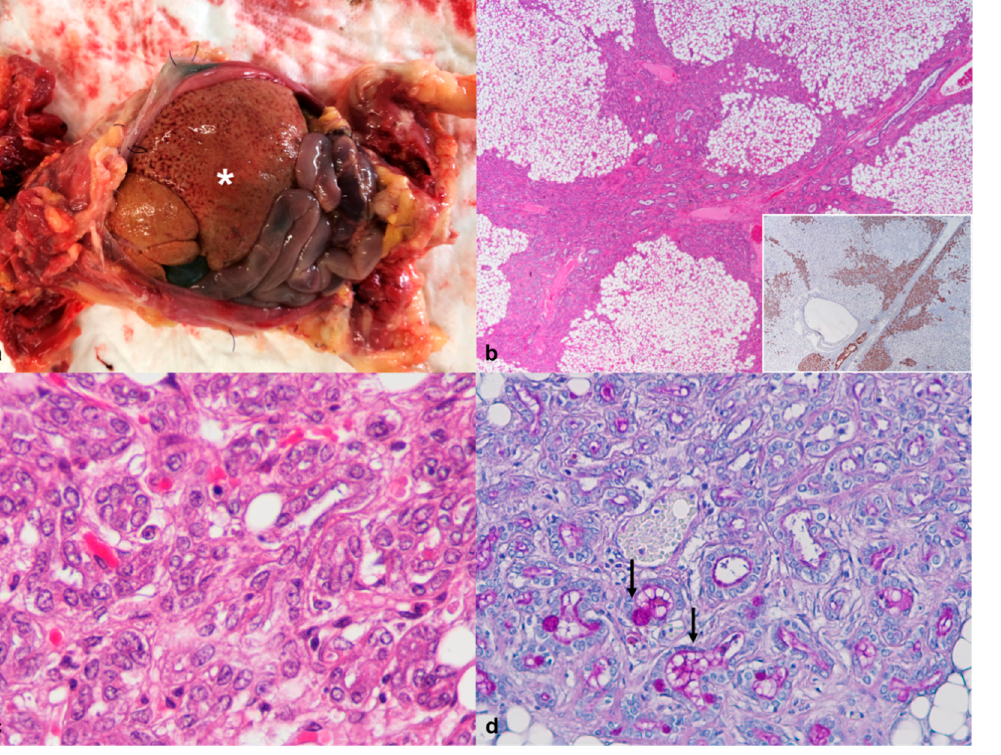
Figure 4. African pygmy hedgehog, liver. Case 4, Bile duct hyperplasia and hepatic steatosis. ( a ) Postmortem examination of the abdominal cavity demonstrating hepatomegaly (*); ( b ) Bile duct hyperplasia. Photomicrograph of the liver showing diffuse macrovesicular steatosis and severe proliferation of bile ducts associated with bridging fibrosis (HE, 20 × ). Inset: The bile duct epithelial cells showing cytokeratin (AE1/AE3) immunoreactivity, (20 × ); ( c ) The hyperplasic bile ducts are lined by cuboidal to polygonal epithelial cells with vesicular nuclei (HE, 400 × ); ( d ) Some of the tubular structures contain a PAS-positive material (arrows; PAS, 200 ×